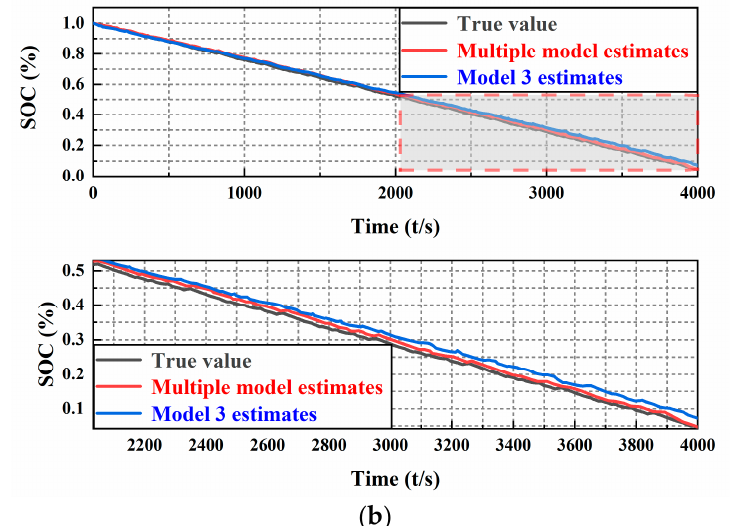
Figure 11. SOC estimation results. ( a ) SOC estimation curves of multi-model and each single-model. ( b ) SOC estimation curves of multi-model and Model 3.